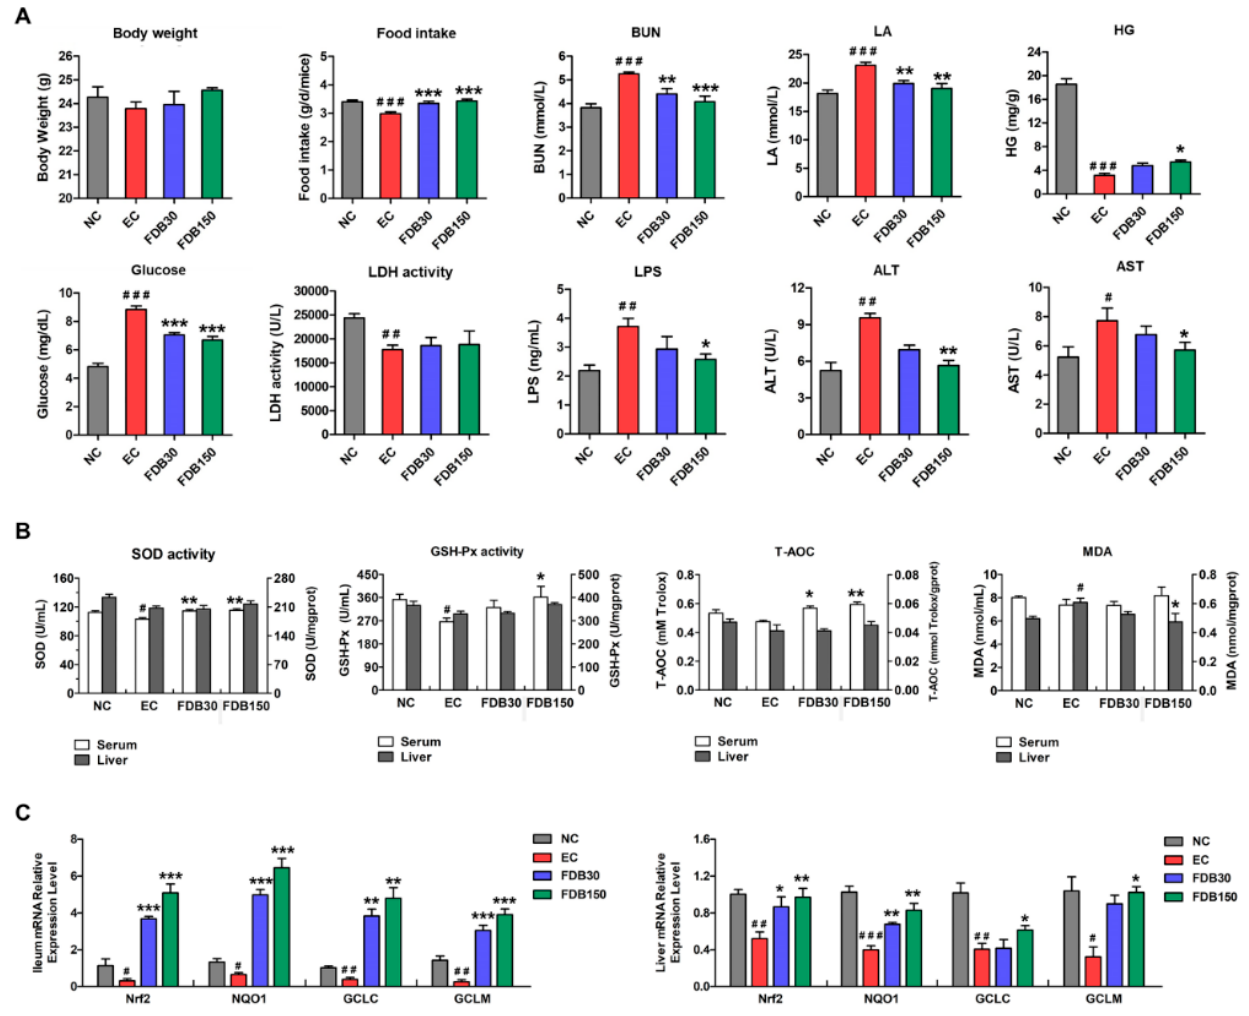
Figure 1. Effects of FDB on ameliorating fatigue and oxidative stress in intense exercise mice. ( A ) Serum biochemical parameters and HG. ( B ) SOD, GSH-Px, T-AOC, and MDA levels in the serum and liver. ( C ) The mRNA expression of oxidative stress-related signaling genes in the ileum and liver. # p < 0.05, # # p < 0.01, and # # # p < 0.001 vs. NC (normal control) group; * p < 0.05, ** p < 0.01, and *** p < 0.001 vs. EC (exercise control) group. FDB30: 30 mg/kg FDB group; FDB150: 150 mg/kg FDB group. BUN: urea nitrogen; LA: lactic acid; HG: hepatic glycogen; LDH: lactate dehydrogenase; LPS: lipopolysaccharide; ALT: alanine aminotransferase; AST: aspartate aminotransferase; SOD: